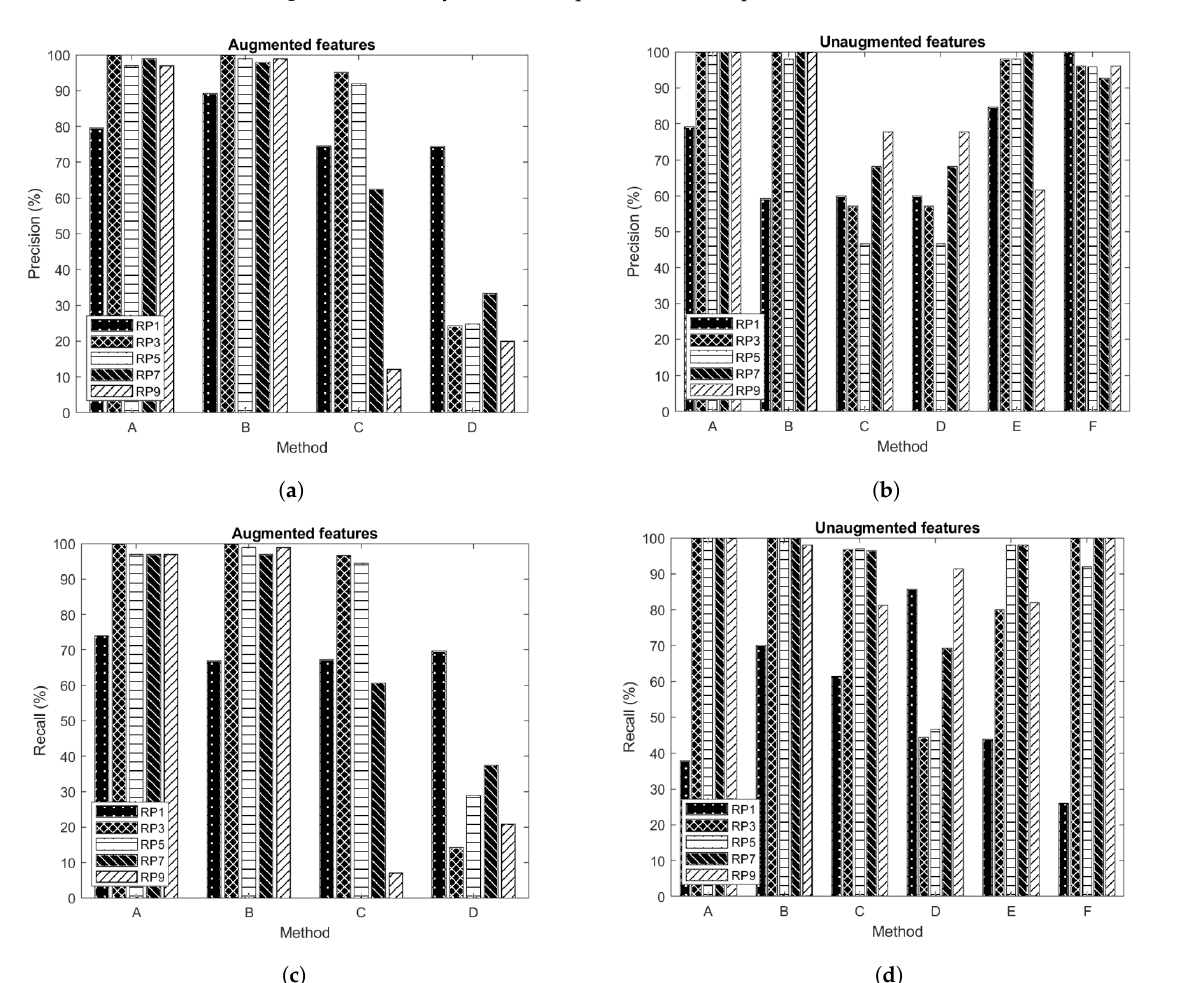
Figure 9. Specific reference point precision ( a , b ) and recall ( c , d ) results for augmented and unaugmented features